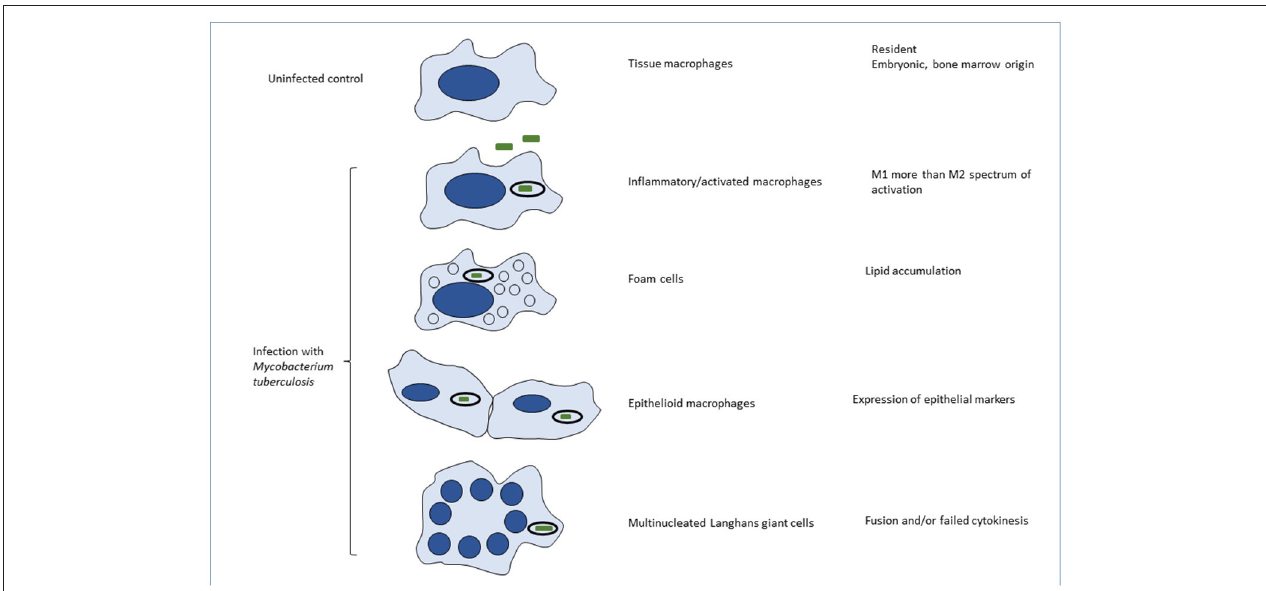
FIGURE 2 | Phenotypic heterogeneity of macrophages induced by MTB infection in vivo . Macrophages are able to undergo remarkable variations in their phenotype in vivo , yet the mechanisms are poorly understood. This is partly the result of species variation, inadequacy of defined in vitro conditions to mimic in vivo phenotypes, limited population and single cell analysis of cells in situ or after extraction, ex vivo , and above all, the complexity and heterogeneity of the mixed populations present in tissues. Variables that have been characterized to some extent, include: ontogeny (embryonic or bone marrow origin); steady state and physiological conditions in different organs and microenvironments; sterile injury and acute or chronic infections such as MTB; cell recruitment, phagocytosis and activation by different exogenous and endogenous stimuli; and cell death by apoptosis, necrosis or pyroptosis. In many situations the macrophage phenotype covers a spectrum of responses, rather than binary alternatives. Their characterization is morphological, utilizing combinations of marker antigens, signatures of gene expression, and, where known, functional differences. The text provides examples of the different phenotypes illustrated here. The impact of macrophage phenotype on MTB infection, and conversely, of MTB infection on macrophage functions is barely